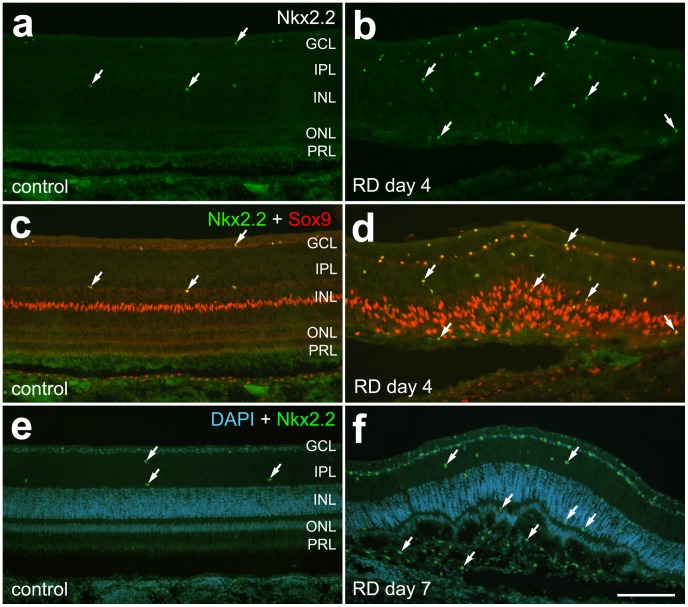
NIRG cells are mildly up-regulated after chick HA RD.NIRG cells (arrows) are positive for Nkx2.2 (green, a–f) and Sox9 (orange, c, d) and are increased after HA RD compared to controls. The up-regulation of NIRGs is less than that of Müller glia (Sox9+/Nkx- cells in the inner nuclear layer and outer retina). NIRGs were identified in subretinal scars (f, arrow; green = Nkx, blue = DAPI).